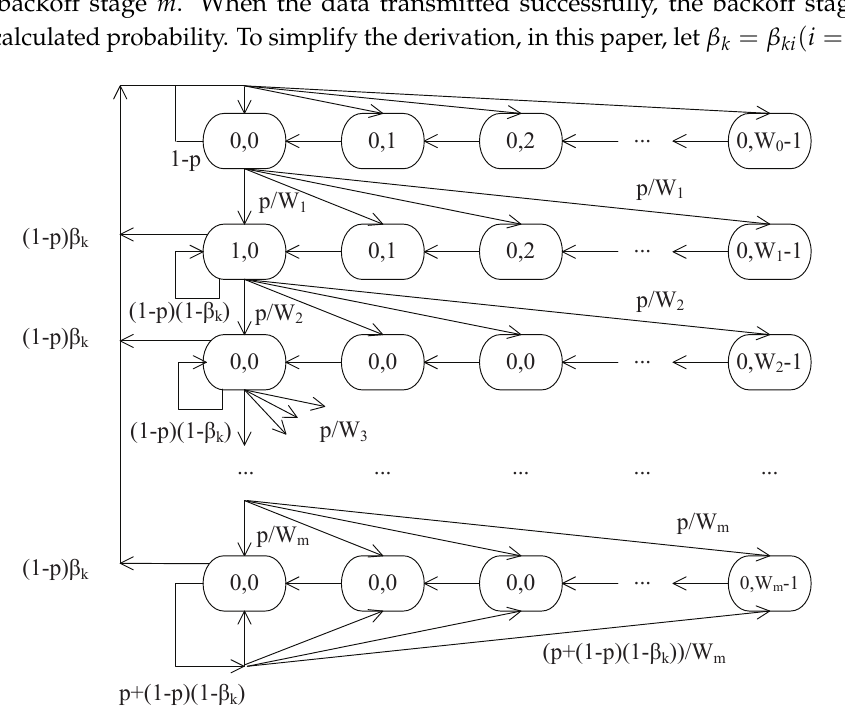
Figure 2. The state transition probability of the Markov